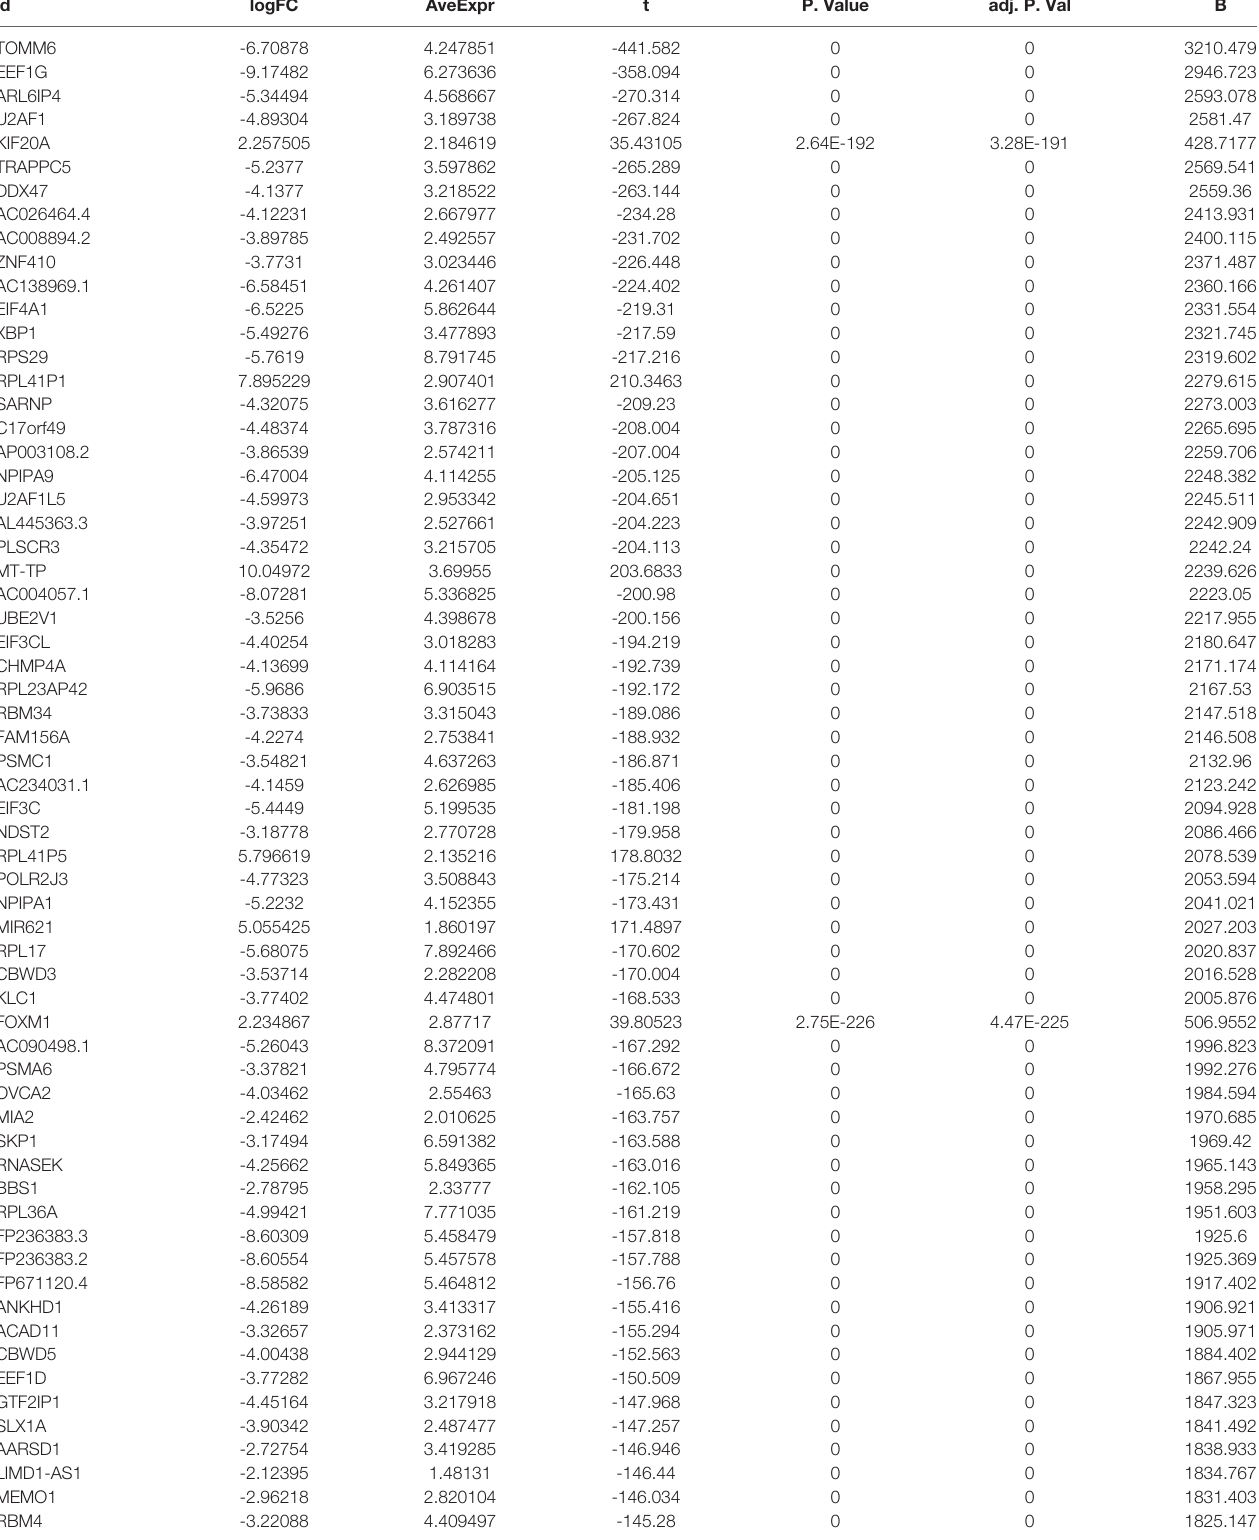
TABLE 2 | Top 100 differentially expressed genes from GEO database differential expression